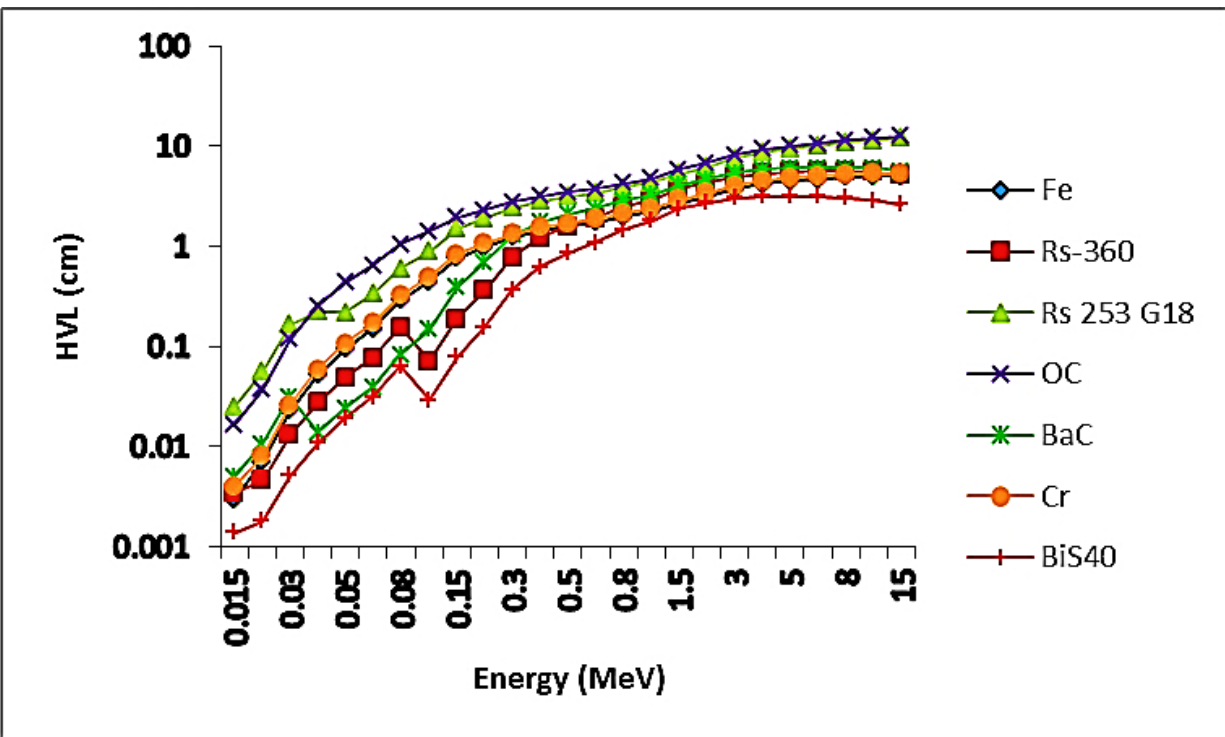
Figure 9. Comparison values of the HVL of the present sample BiS40 with commercial materials.